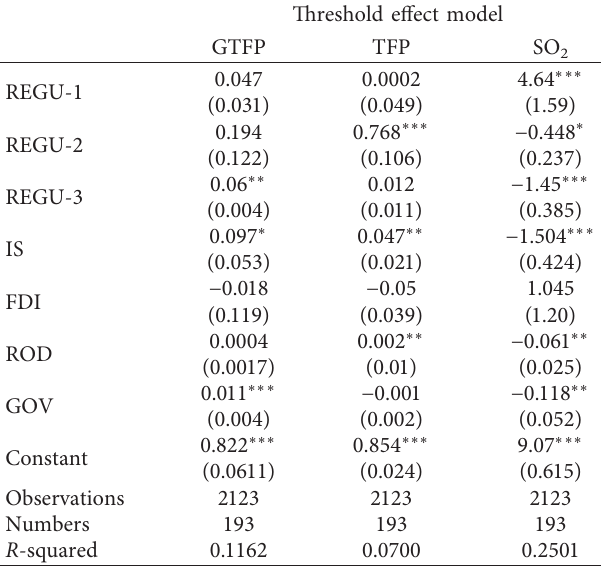
Table 5: The impact of innovation on productivity and pollutants under environmental